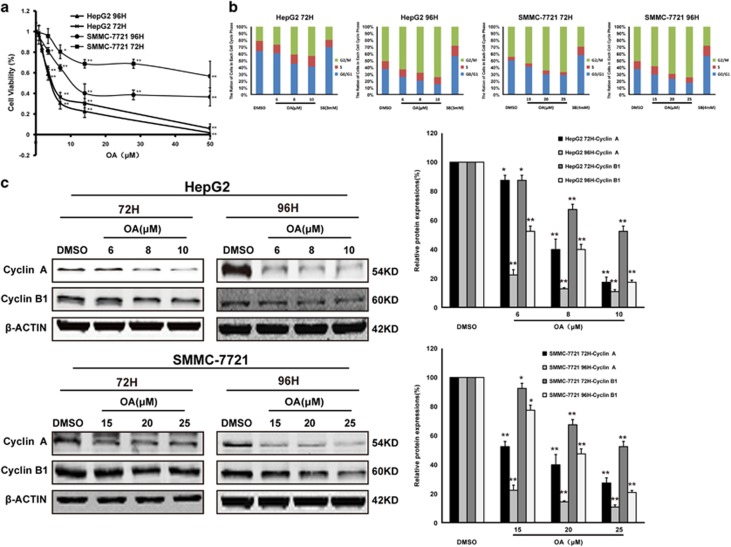
OA inhibited the proliferation and induced cell cycle arrest of hepatocarcinoma cells. (a) Cell viability of HepG2 and SMMC-7721 cells treated with various concentrations of OA were measured by MTT assay after 72 and 96 h treatment. (b) PI staining was analyzed by flow cytometry. (c) The whole-cell lysates were prepared and subjected to WB for cell cycle-related proteins. Bars, SD. *P<0.05 or **P<0.01 versus DMSO-treated cells